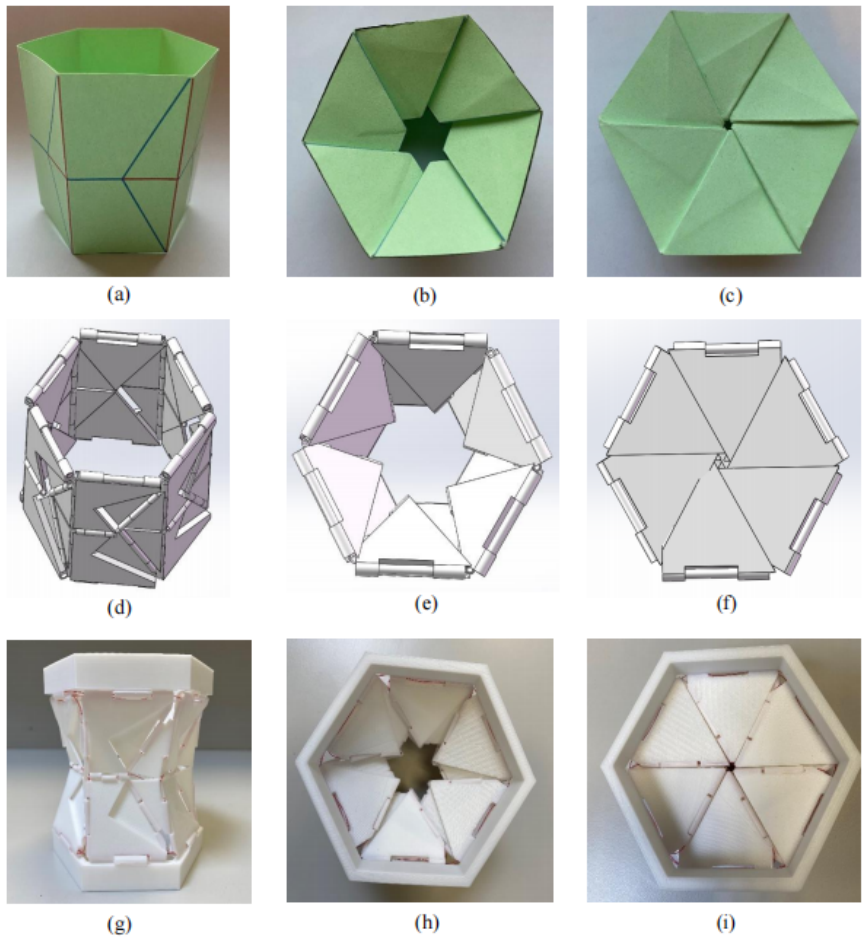
Figure 12. Simplified rigid RC-ori prototype made by 3D printer. ( n = 6) ( a – c ) is the folding process of a paper model. ( d – f ) is the folding process of a Solidworks a printed model connected by flexible lines. https://youtube.com/shorts/E0uF6XN1cNQ (accessed on 25 August 2022)